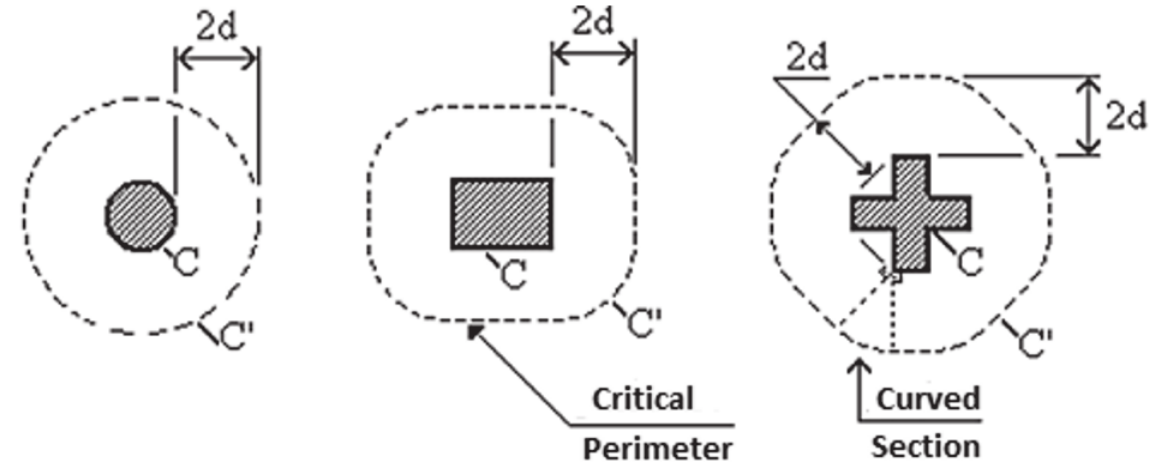
Perimeters C and C’ to different geometries of internal